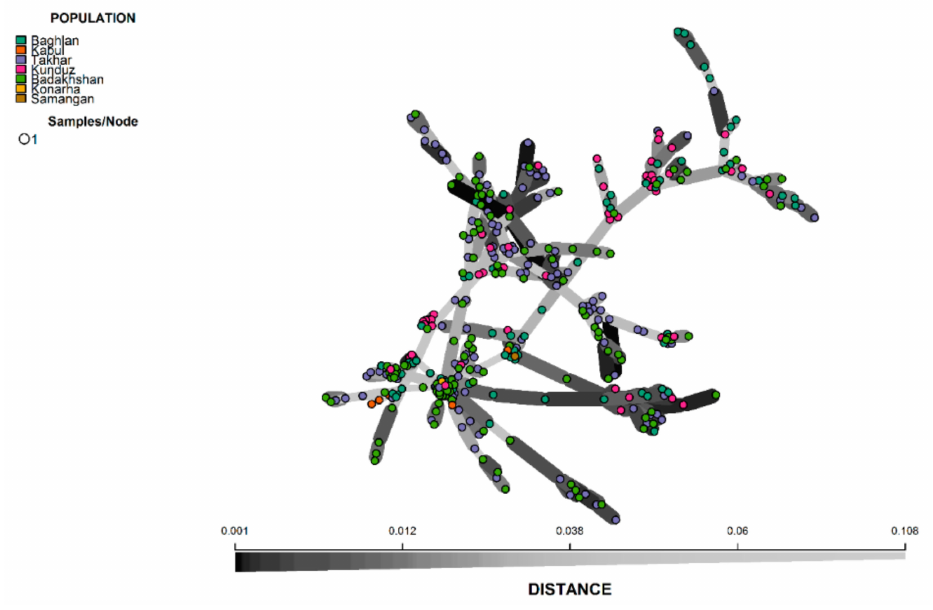
Figure 7. Minimum spanning network (MSN) of 363 Afghan bread wheat